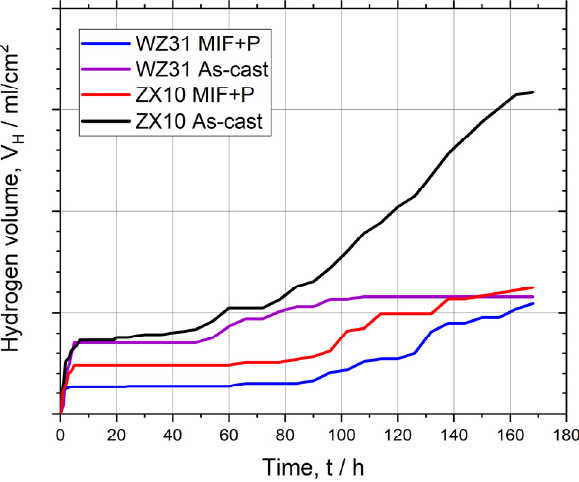
Figure 4. Hydrogen evolution plots in WZ31 and ZX10 alloys with different microstructures in Hank’s solution thermostabilized at 37 °C and maintained at pH = 7.0 (adapted from [144]).